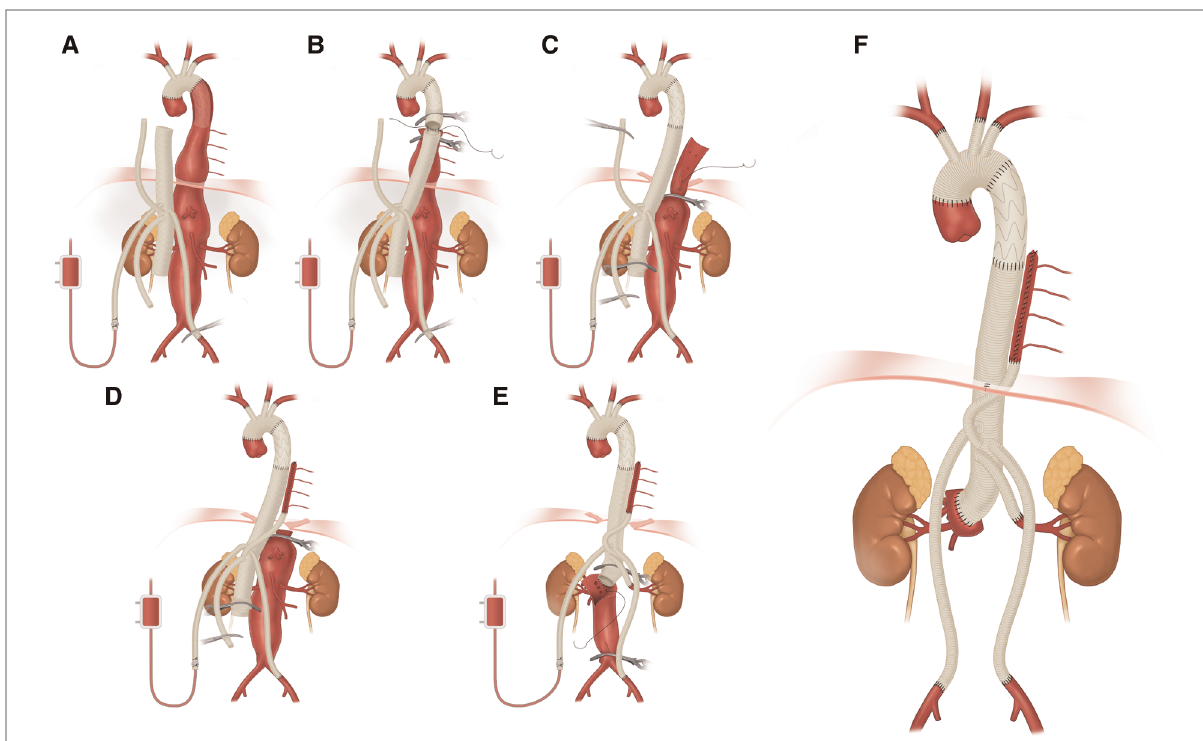
FIGURE 1 Thoracoabdominal aortic repair with normothermic iliac perfusion. ( A ) Anastomosis of left common iliac artery; ( B ) Proximal anastomosis; ( C,D ) Tube technique to restore the blood fl ow to the spinal cord; ( E ) Anastomosis of SMA, the celiac axis and the renal artery; ( F ) Anastomosis of right common iliac